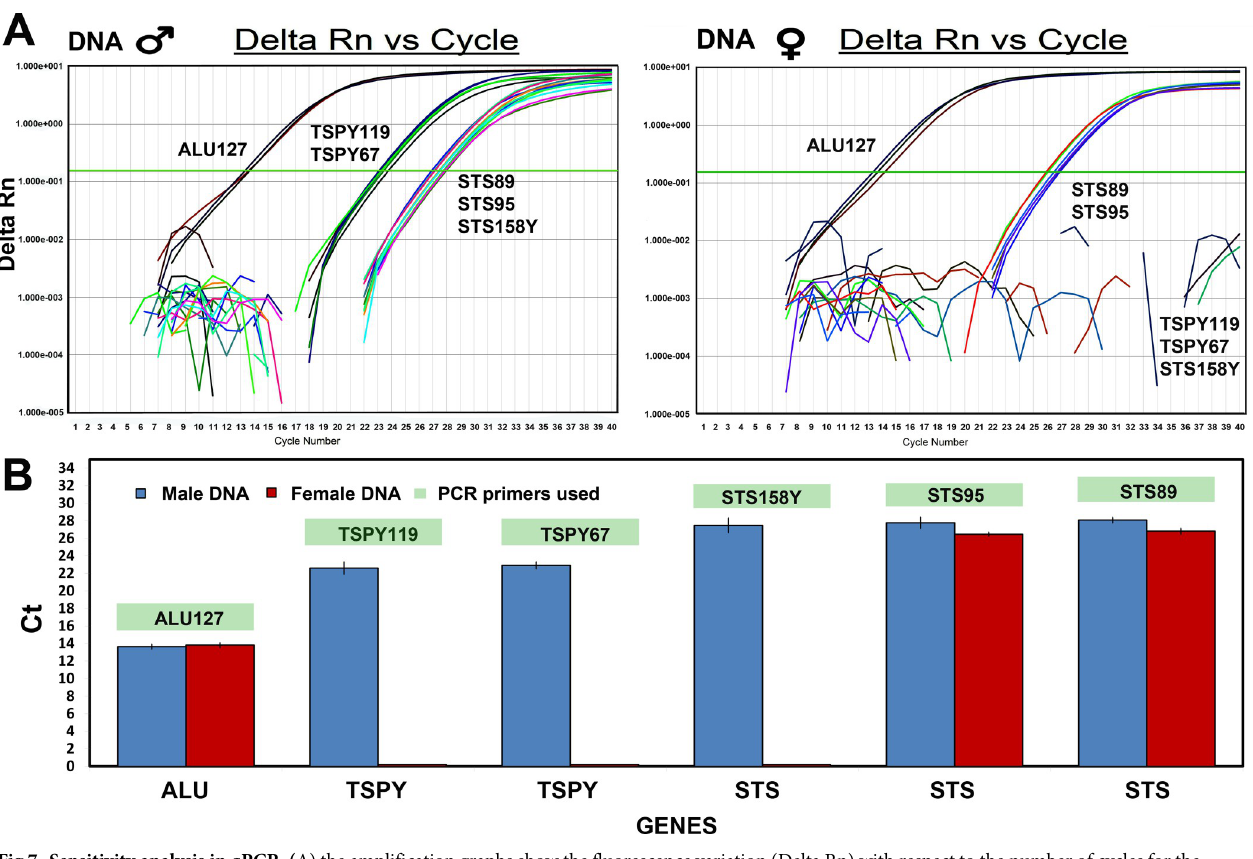
Fig 7. Sensitivity analysis in qPCR. ( A) the amplification graphs show the fluorescence variation (Delta Rn) with respect to the number of cycles for the different amplicons obtained with the primers: ALU127 , TSPY119 , TSPY67 , STS89 , STS95 , STS158Y ; 400 pg of male and female DNA were used in the reaction system. B) the graph shows the mean Ct values of genes amplified using DNA from both sexes. The blue columns represent the male DNA, the red columns the female DNA.